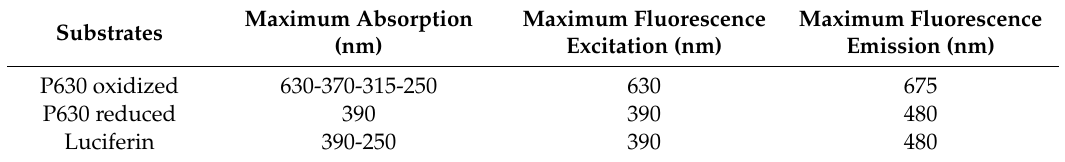
Table 2. Absorption, fluorescence excitation, and emission maxima (nm) of P630 oxidized,